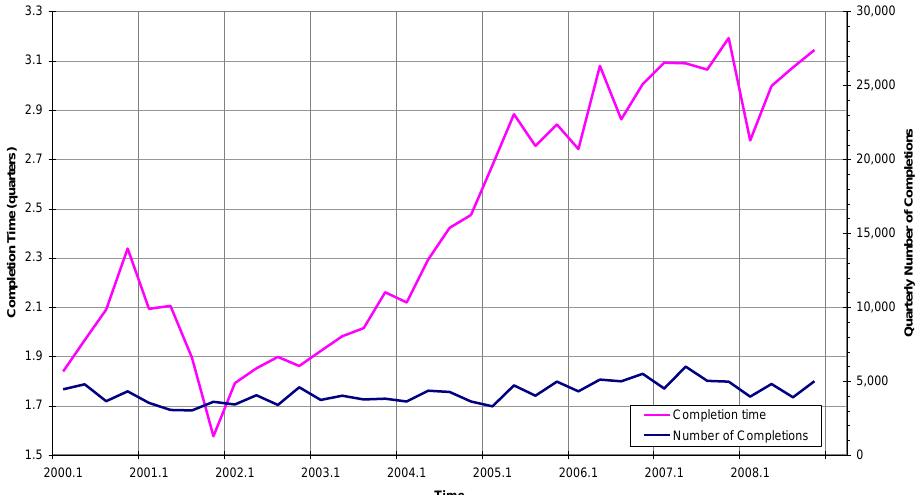
Figure 2: Average house completion time and quarterly number of completions in Western